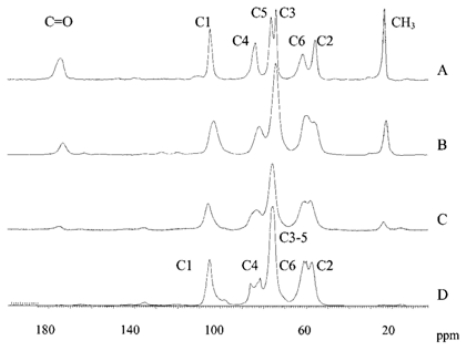
13C CP-MAS NMR spectra of samples A-D (with decreasing DA; ~100%, ~60%, ~20%, ~0%). Reprinted with permission from Biomacromolecules. 2008, 1, 746–751. Copyright 2010, American Chemical Society [280].